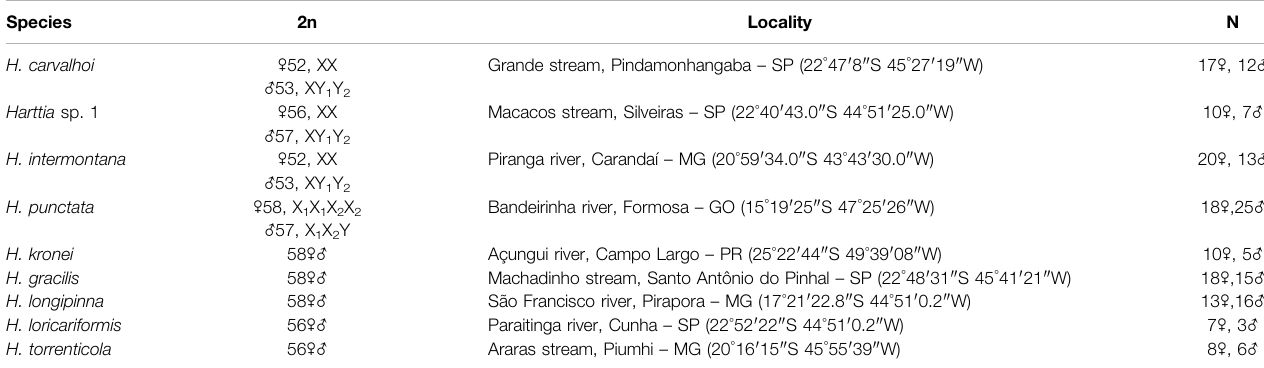
TABLE 1 | Collection sites of the studied species, diploid chromosome number (2n), and sample size (N). Species 2n Locality